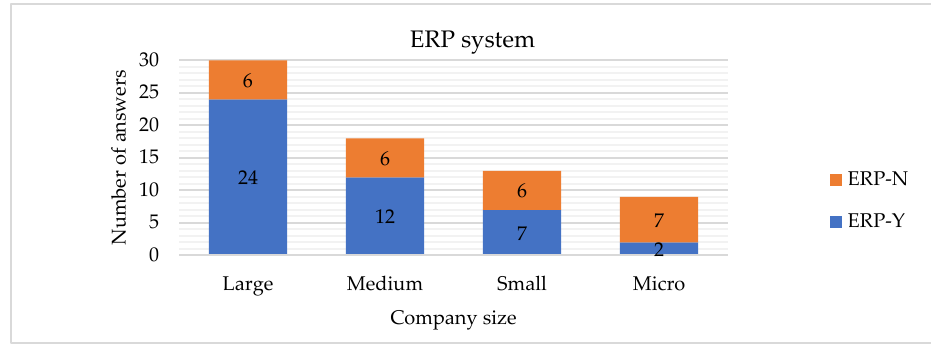
Figure 23. Number of companies having ERP system implemented (ERP-Y) or not (ERP-N) by company size.